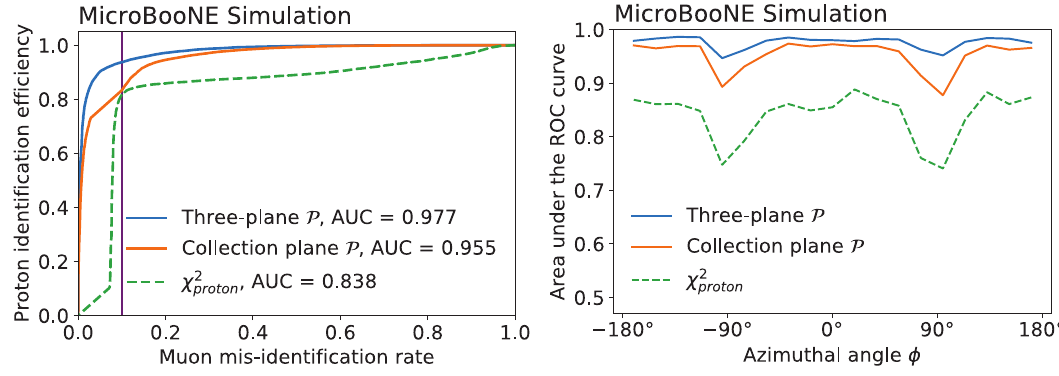
Figure 5. Comparison of the proton/muon separation power of different PID scores. The left plot shows the ROC curves on the entire sample, and the right plot shows the area under the curve (AUC) in bins of the track angle φ . The blue curves refer to the proposed PID score P using three planes, the orange refer to the collection plane only P , whereas the green curves show the χ 2 test with respect to the proton hypothesis. The purple vertical line on the left plot slices the curves at muon mis-identification rate 0.1, comparing the proton identification efficiencies of the three methods at the same working